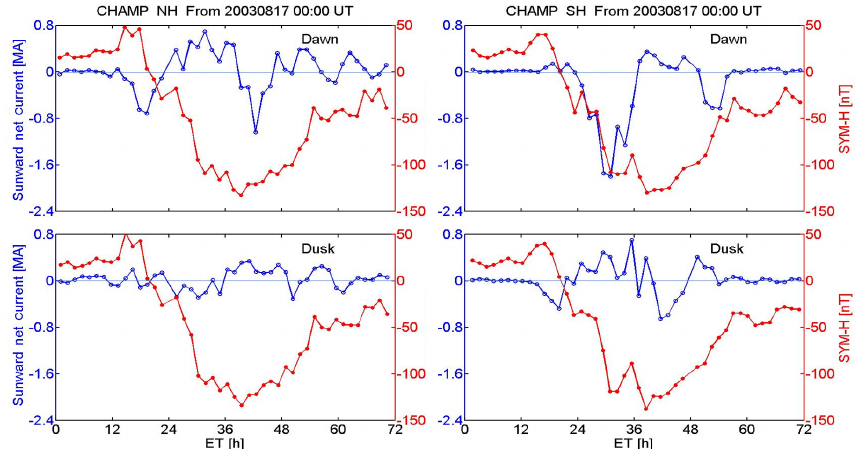
Figure 8. Temporal evolutions of the SYM-H index and the net currents separately for both hemispheres and for dawnside and duskside during the storm on 17–20 August 2003. Magnetic local time ranges are the following. NH dawn passes: 06:00–09:00MLT, NH dusk passes: 17:00–21:00MLT, SH dawn passes: 03:00–10:00MLT, and SH dusk passes: